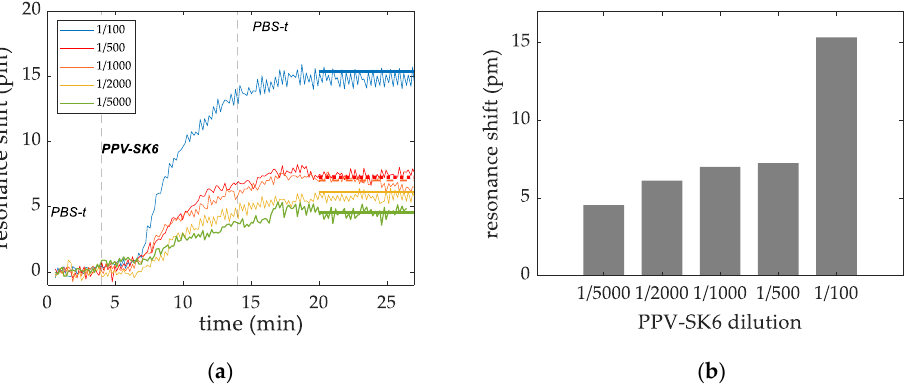
Figure 5. ( a ) Dose dependence signal shift (measured in pm) for pAb (alpha diagnostic) for each PPV dilution tested. The detection level for each dilution was obtained as the average shift of the data acquired after the rinse step and depicted as a horizontal line. ( b ) The detection levels for each dilution tested are summarized in a bar